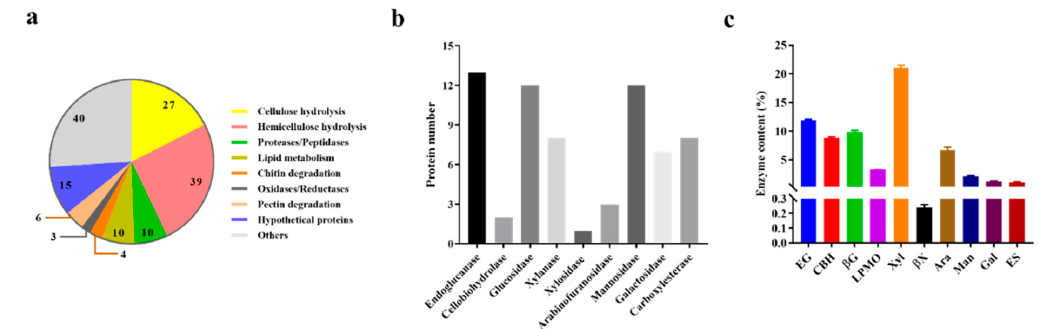
Figure 2. Functional classification of enzymes secreted by T. harzianum EM0925. ( a ) Functional classification of T. harzianum EM0925 enzyme cocktail; ( b ) numbers of different lignocellulosic enzyme in proteome of T. harzianum EM0925. ( c ) Abundance of lignocellulose degradading enzymes in the proteome of T. harzianum EM0925. EG, Endoglucanase; CBH, cellobiohydrolase; β G, β - glucosidase; LPMO, lytic polysaccharide monooxygenase; Xyl, xylanase; β X, β -xylosidase; Ara, arabinofuranosidase; Man, mannosidase; Gal, galactosidases; ES, carboxylesterase.